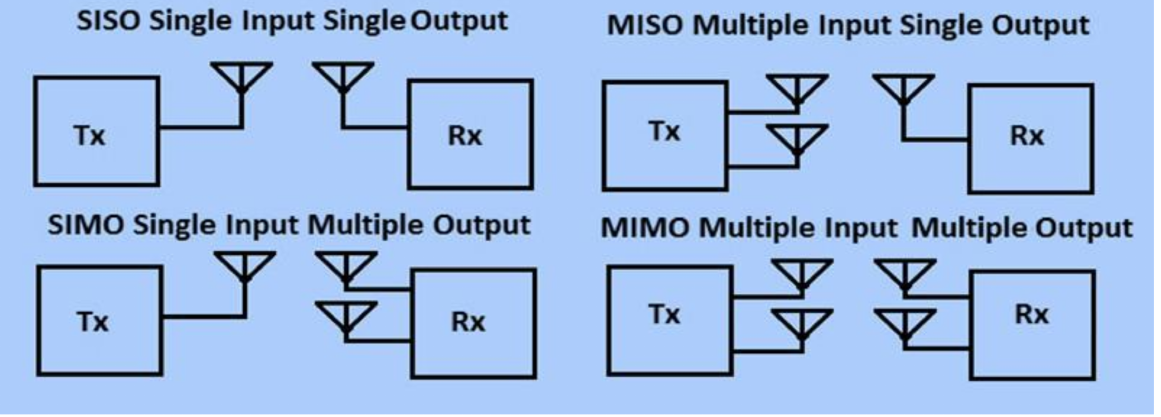
Figure 6. Types of MIMO approaches in the design of the